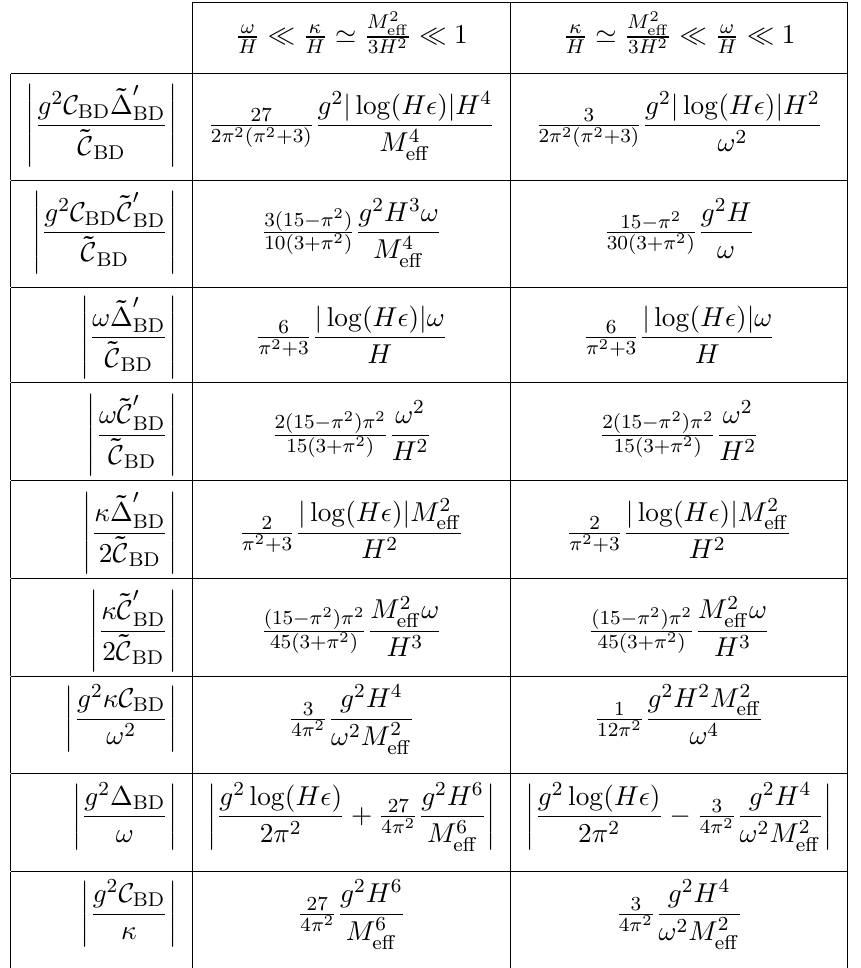
Table 6 . Leading-order behaviour of the functions in the validity bounds (4.38) and (4.39) (the sizes of all which must be (cid:28) 1), using information from table 5 (and also table 2). The bounds (4.28){ (4.30) are also included, keeping in mind that g 2 C BD =(cid:20) ’ 2 g 2 Re[ W 0 ] = ( (cid:20) 2 + ! 2 ) in the regimes quoted. Note that some of the bounds are trivially satis(cid:12)ed in the quoted regimes (for